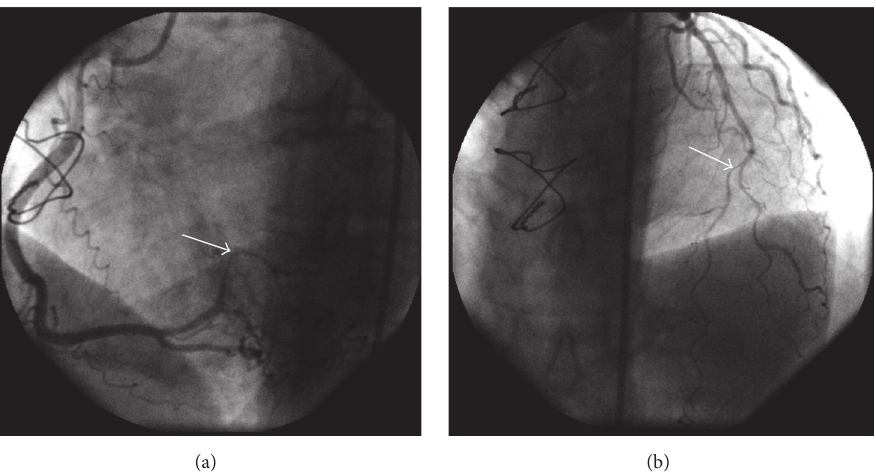
Figure 1: Coronary angiography showed posterior branch of the right coronary artery with a severe stenosis (90%) (a) and medium segment of the anterior descendent artery suboccluded (70%)